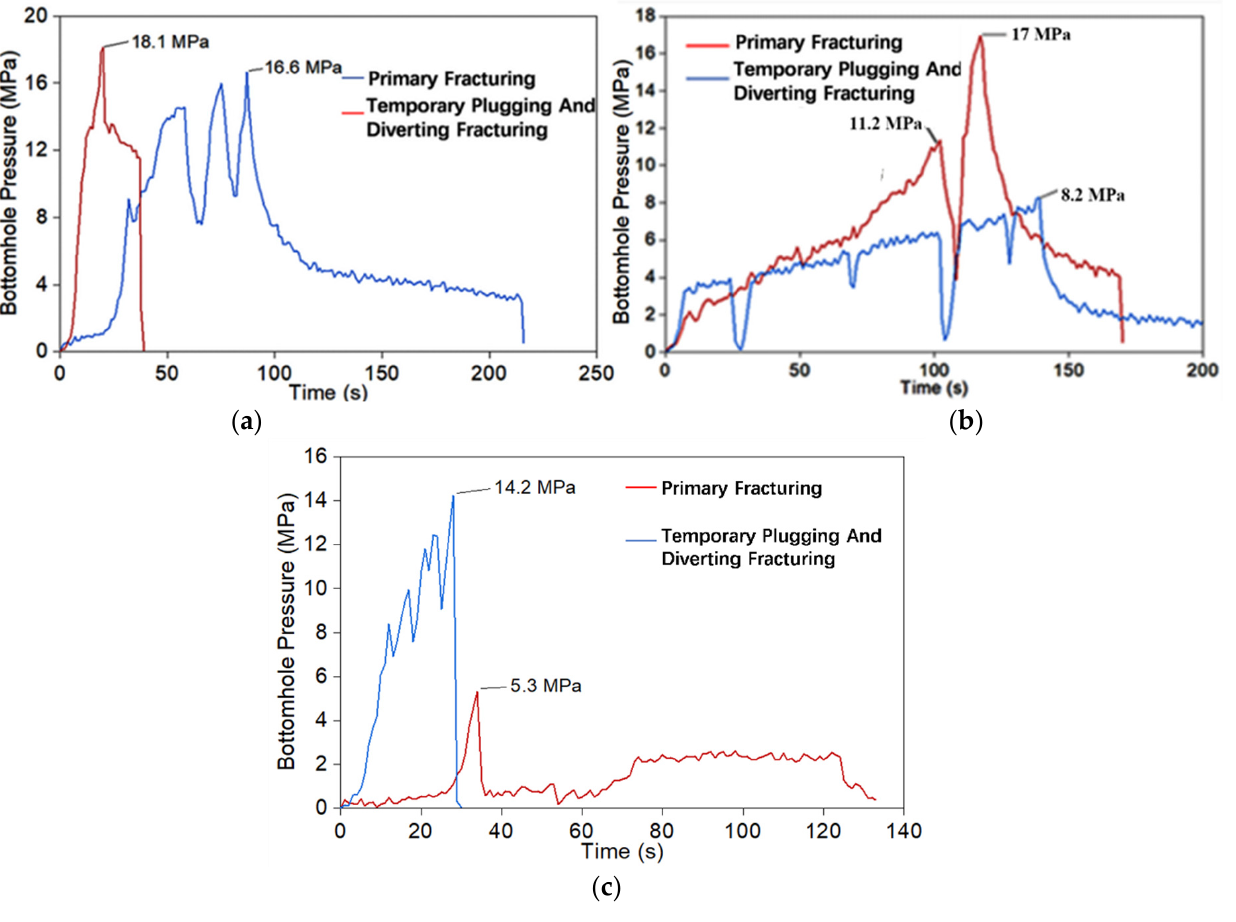
Figure 10. Pressure curves of coal samples 2#, 6#, and 7#: ( a ) pressure curves of sample 6#; ( b ) pressure curves of sample 2#; ( c ) pressure curves of sample 7#.